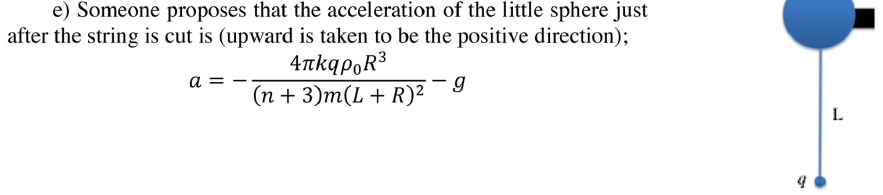
FIG. 10. Proposed formula for the acceleration of a small charged